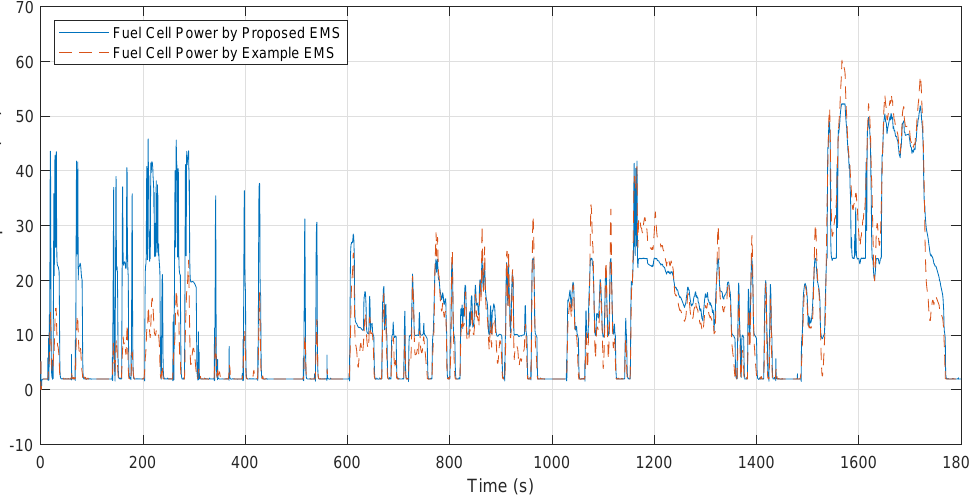
Figure 15. Comparison of fuel-cell output power.